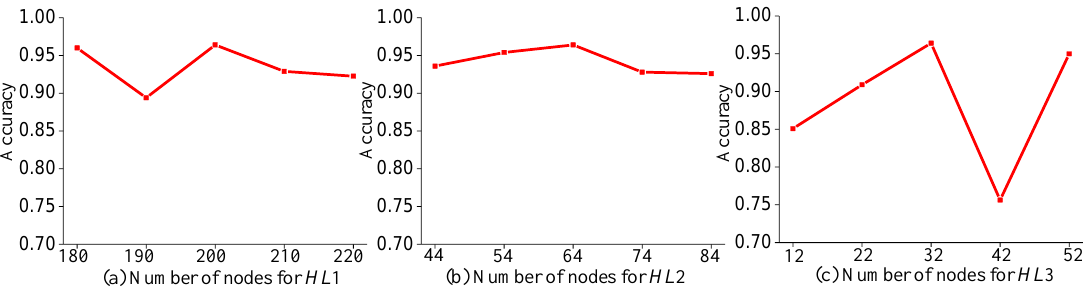
Figure 14. The performance of ANN-BP with varied of hidden layers ( HL s).